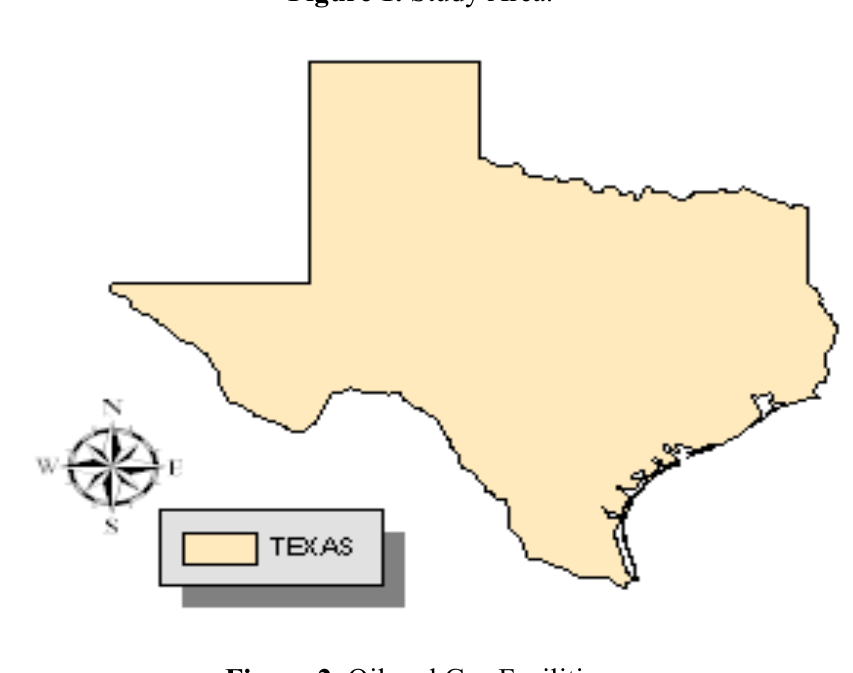
Figure 2. Oil and Gas Facilities.